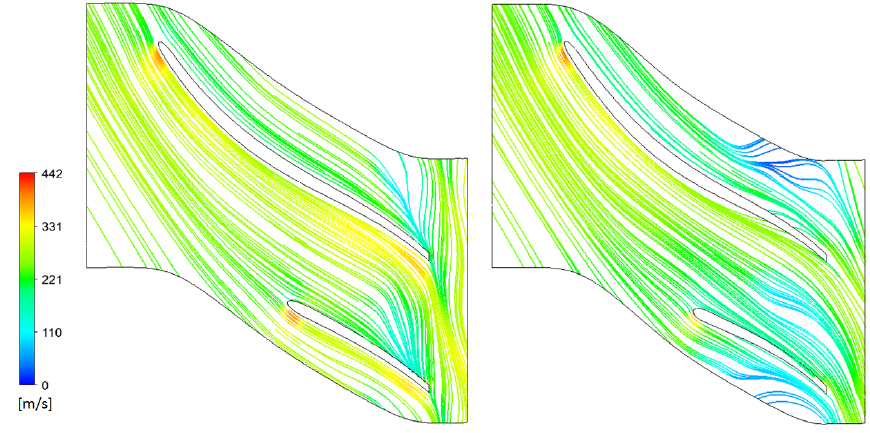
} (right) at span = B + B + B − 2 3 1 4